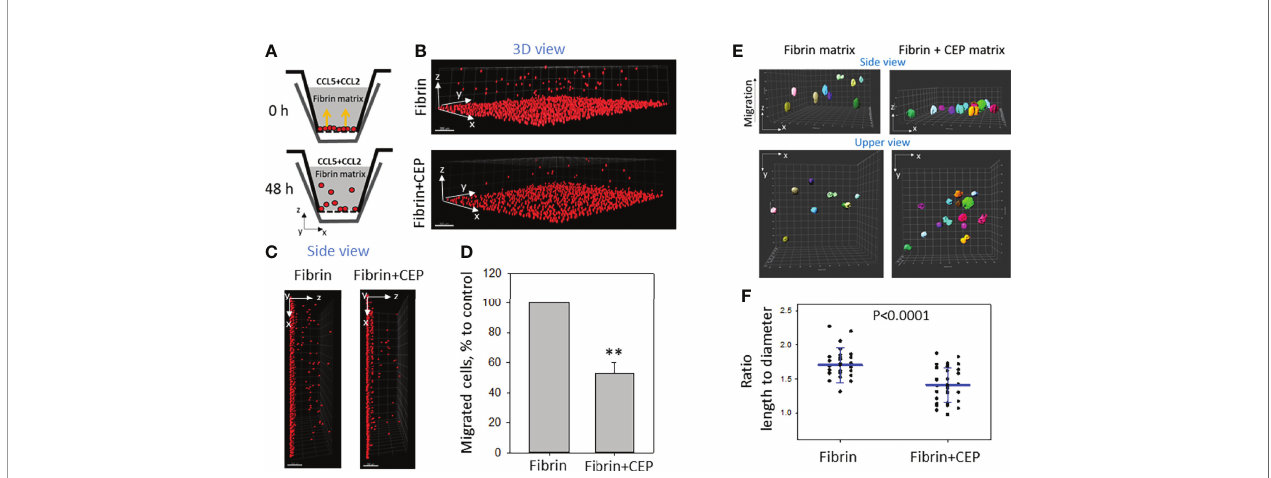
FIGURE 4 | The presence of CEP in the matrix inhibits the 3D migration of M1 macrophages. (A) Sketch diagram of the migrating cells in Boyden transwell chamber. Before migration (upper panel) and after 48h migration (lower panel). (B) WT M1 macrophages were labeled with red PKH26 fl uorescent dye. Labeled WT (1.5x10 5 ) activated macrophages were plated on the membranes of transwell inserts (Boyden chamber) with a pore size of 8 m m and 6.5 mm in diameter (Costar, Corning, NY) precoated with fi brinogen (Fg). Fibrin gel (100 µl/sample) was generated by mixing 0.75mg/ml Fg containing 1% FBS and 1% P/S and 0.5 U/ml thrombin with or without 9uM CEP. Migration of macrophages was stimulated by 30 nM CCL2 and 100nM CCL5 added to the top of the gel. After 48 hours, migrating cells were detected by a Leica Confocal microscope (B, C) . (D) The results were analyzed by IMARIS 8.0 software, and statistical analyses were performed using Student ’ s paired t-tests (n = 5 per group). Scale bar= 300 m m. Data are presented as mean ± SEM. **P < 0.01. (E) The morphology of non-labeled macrophages was evaluated after gel staining with CytoPainet Phalloidinin-iFluor 555 in fi brin matrix (left panel) and Fibrin matrix supplemented with CEP (right panel). The ratio length/diameter was calculated using the ImarisCell module (IMARIS 8.0). (F) Statistical analyses were performed using Student ’ s t-tests, n = 30 ( fi brin gel) 36 ( fi brin+CEP gel). P <